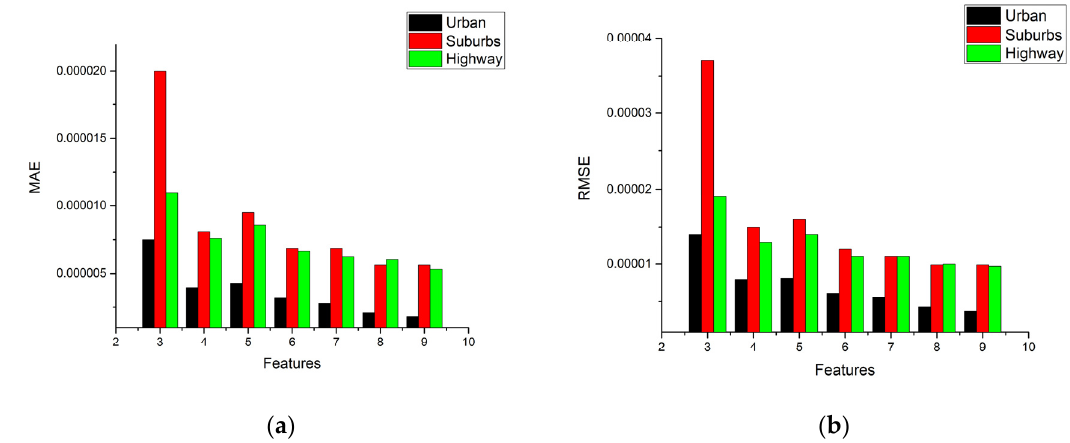
Figure 8. Performance MAE and RMSE statistics results of NO x model ( a ) MAE; ( b ) RMSE.